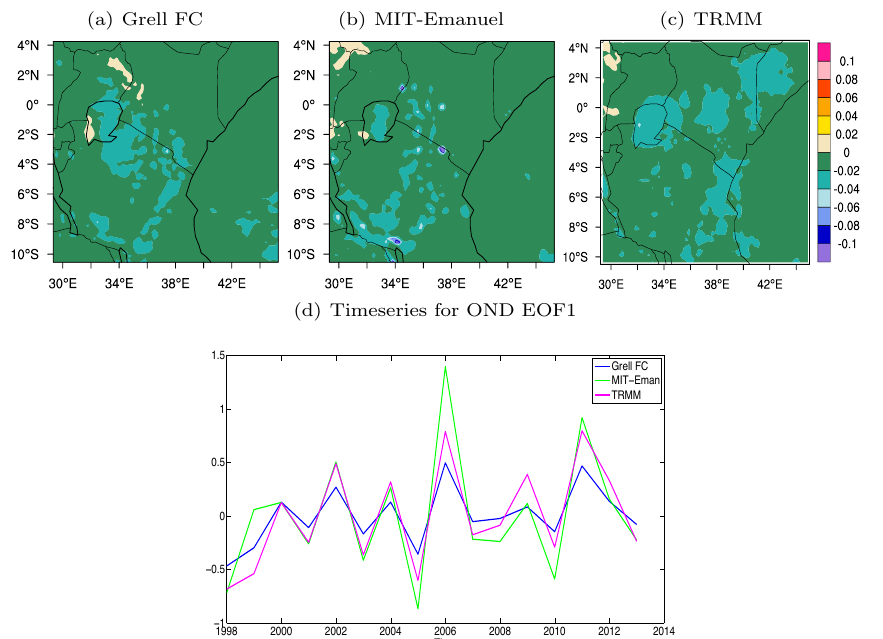
Figure 8. Spatial and temporal distribution for Short Rains Empirical Orthogonal Function (EOF1) precipitation from the RegCM model and observation over the East Africa domain ( a ) Grell FC, ( b ) MIT Emanuel, ( c ) TRMM, and ( d ) Timeseries plot for EOF1. Table 3. Summary of the correlation of TRMM and model output EOF1 with the different indices used in the study for the Short Rains Season over the East Africa region. The ** indicates correlations that are statistically significant at 95% and * at 90%, significance of correlation was done using a Student’s t -test. Model DMI Nino